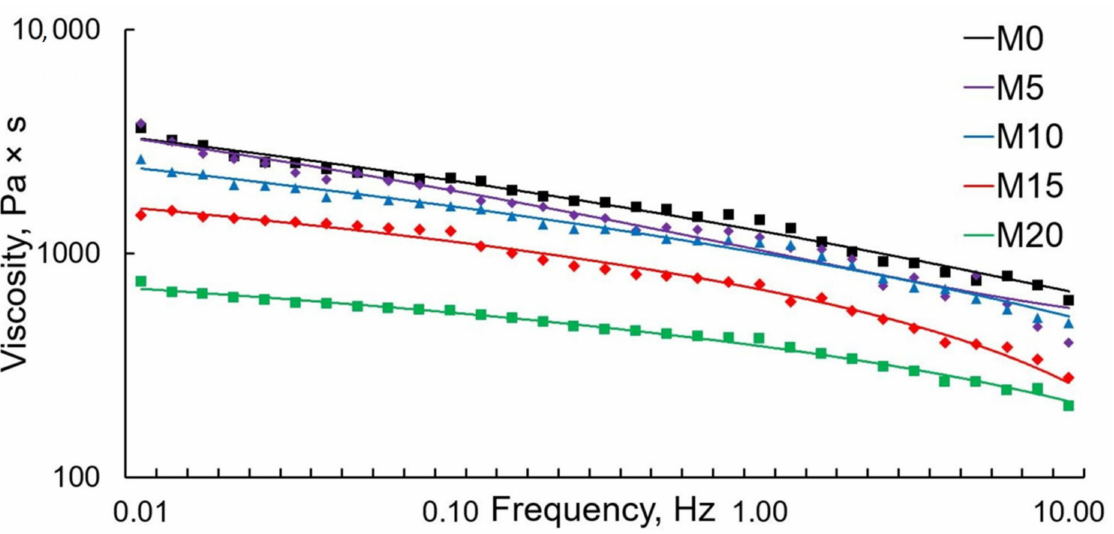
Figure 5. Correlation between viscosity and